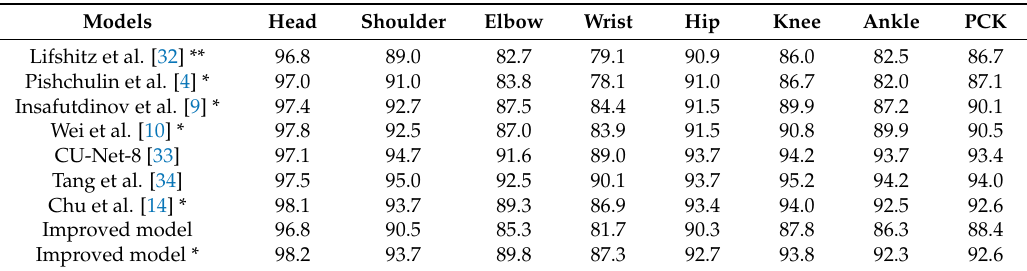
Table 7. The accuracy of the nine models.